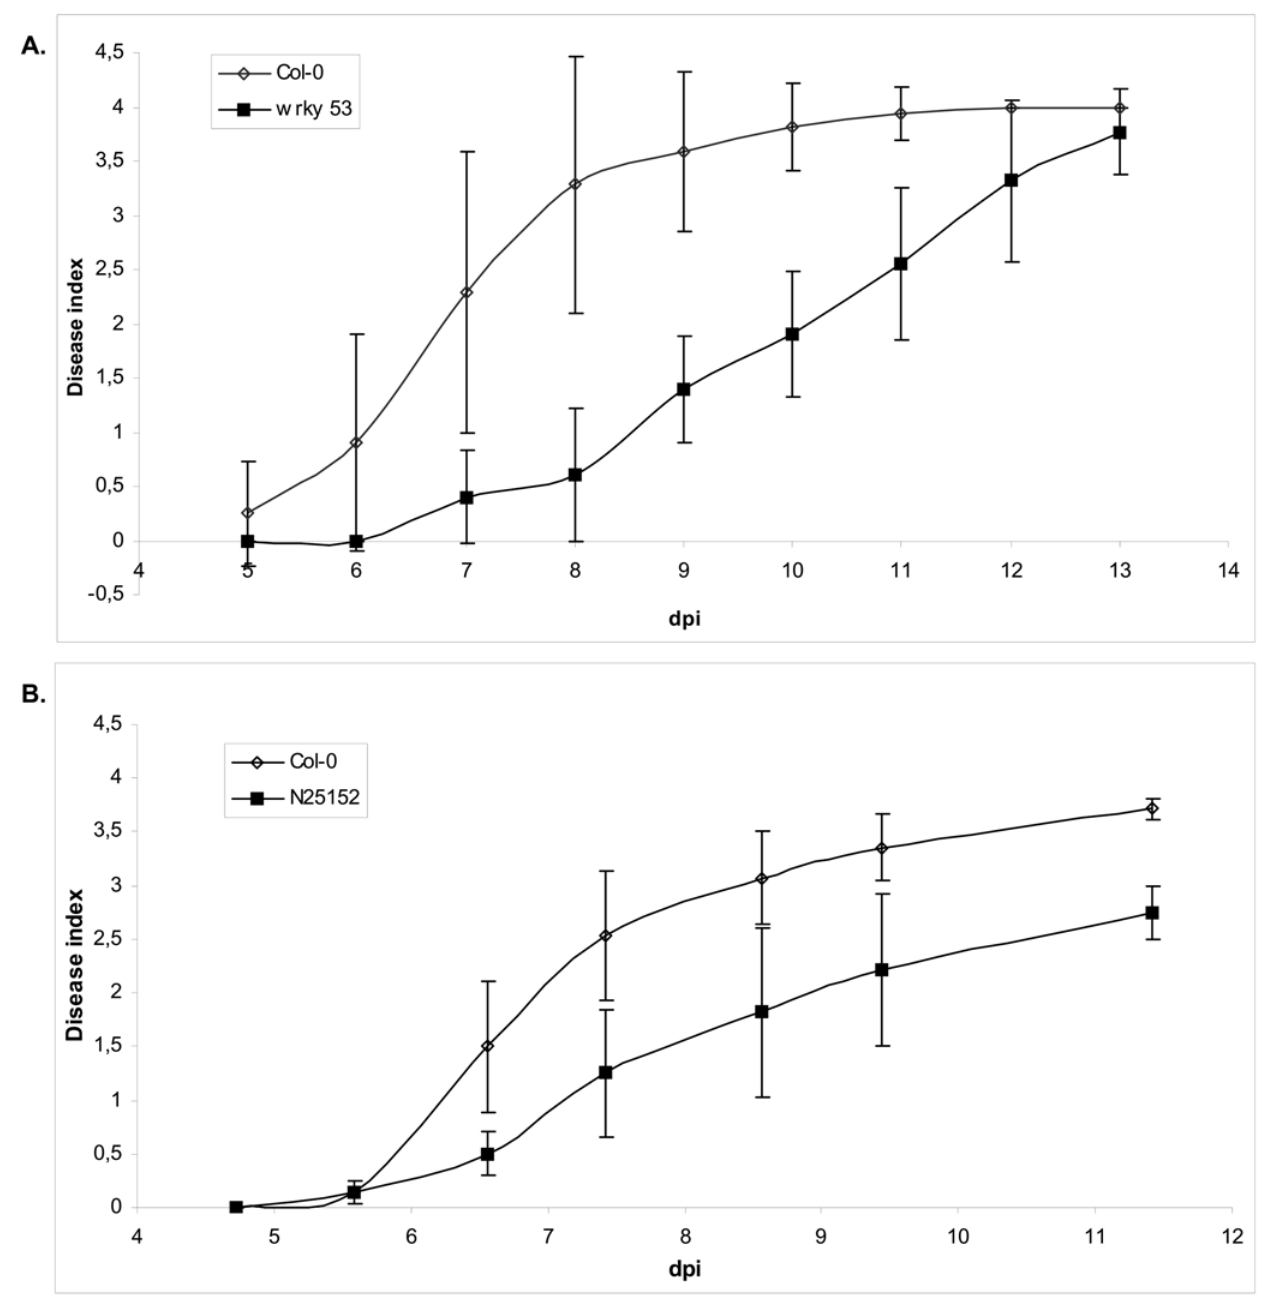
Figure 5. Symptom development in knockout mutant lines for WRKY53 (At4g23810), N25152 (At2g17220) and Col-0 plants. Means presented were calculated for 16 plants per plant line. Thirty mutant (filled square) and wild-type plants (open diamond) were root-inoculated with strain GMI1000 at a concentration of 10 7 bacteria per milliliter. Plants were considered completely wilted when 100% of the rosette leaves were wilted (Disease index 4). This experiment was repeated three times with reproducible results. dpi: day post inoculation.